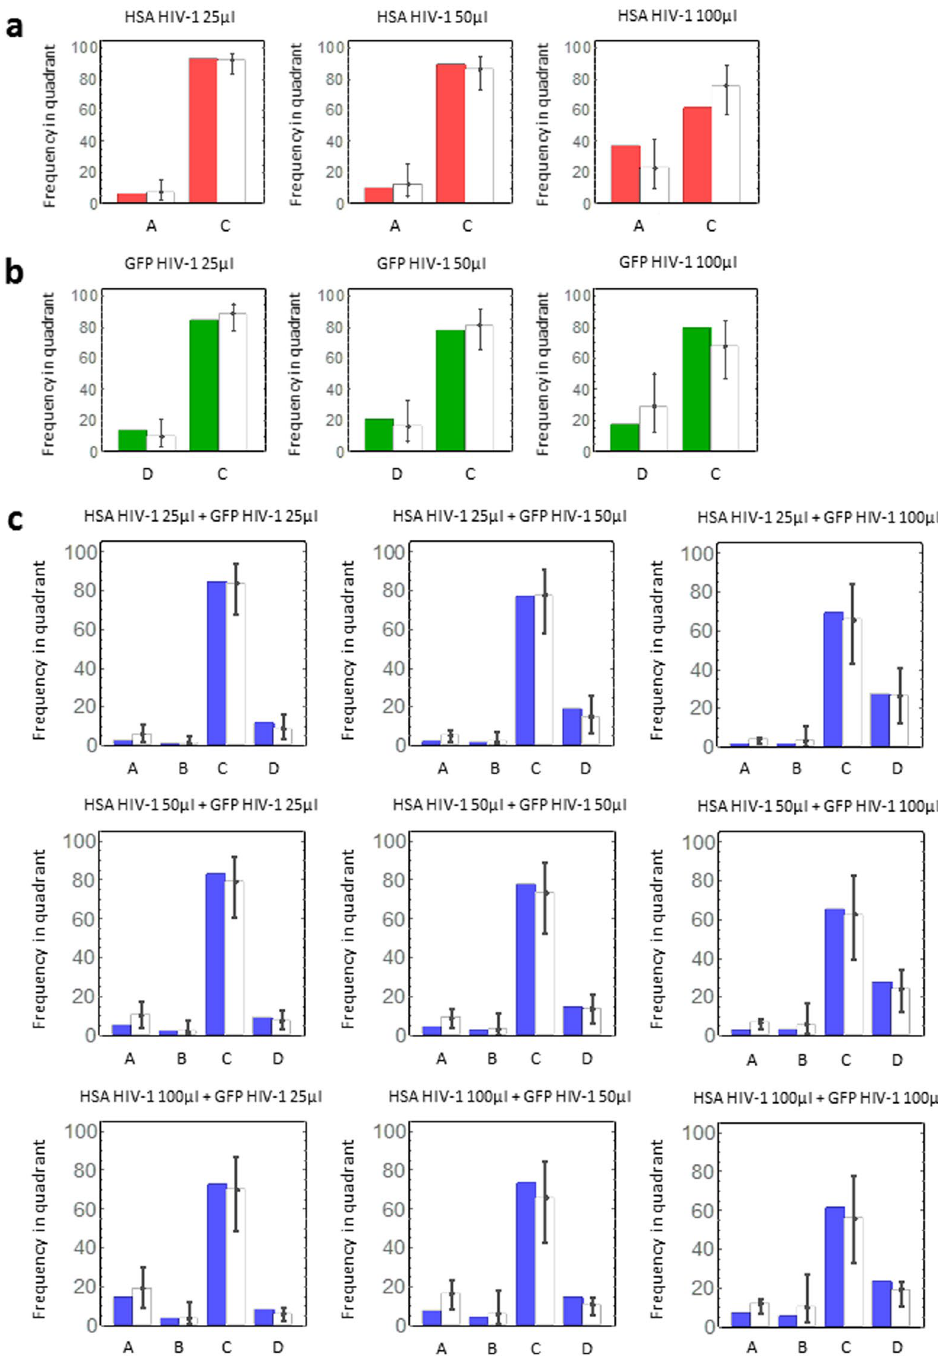
Figure 2. Frequency of single infection and coinfection: ( a) The experimental and theoretical frequencies of quadrants A (i.e., HSA-positive) and C (i.e., HSA-negative) in three independent experiments using only HSA HIV-1 are shown by red and white bars, respectively. (b) The experimental and theoretical frequencies of quadrants D (i.e., GFP-positive) and C (i.e., GFP-negative) in single GFP HIV-1 experiments are shown by green and white bars, respectively. (c) The experimental and theoretical frequencies of quadrants A (i.e., HSA-positive), B (i.e., positive both for HSA and GFP), C (i.e., negative both for HSA and GFP), and D (i.e., GFP-positive) in double HIV-1 experiments are shown by blue and white bars, respectively. Two independent experiments were run with the nine indicated combinations of HSA and GFP HIV-1 corresponding to all possible combinations of the three different amounts of each virus used in single experiments. Note that each error bar represents the 95% credible interval obtained from Markov Chain Monte Carlo (MCMC) parameter inferences (Table